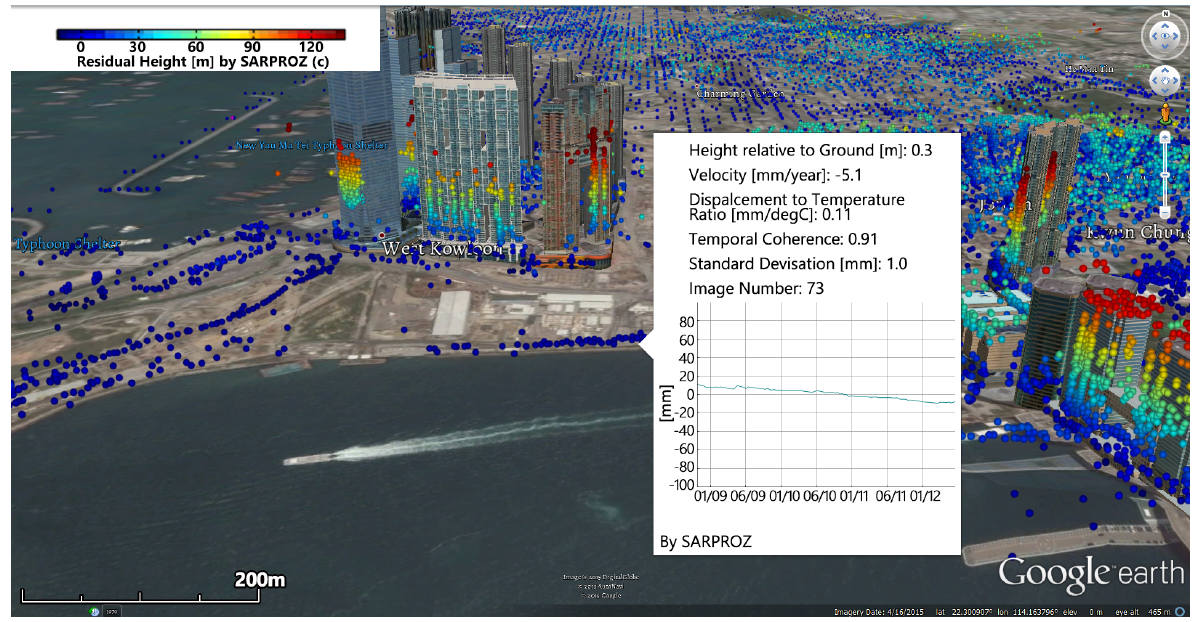
Figure 10. A PS point detected along the coastal area and near the CR validation test